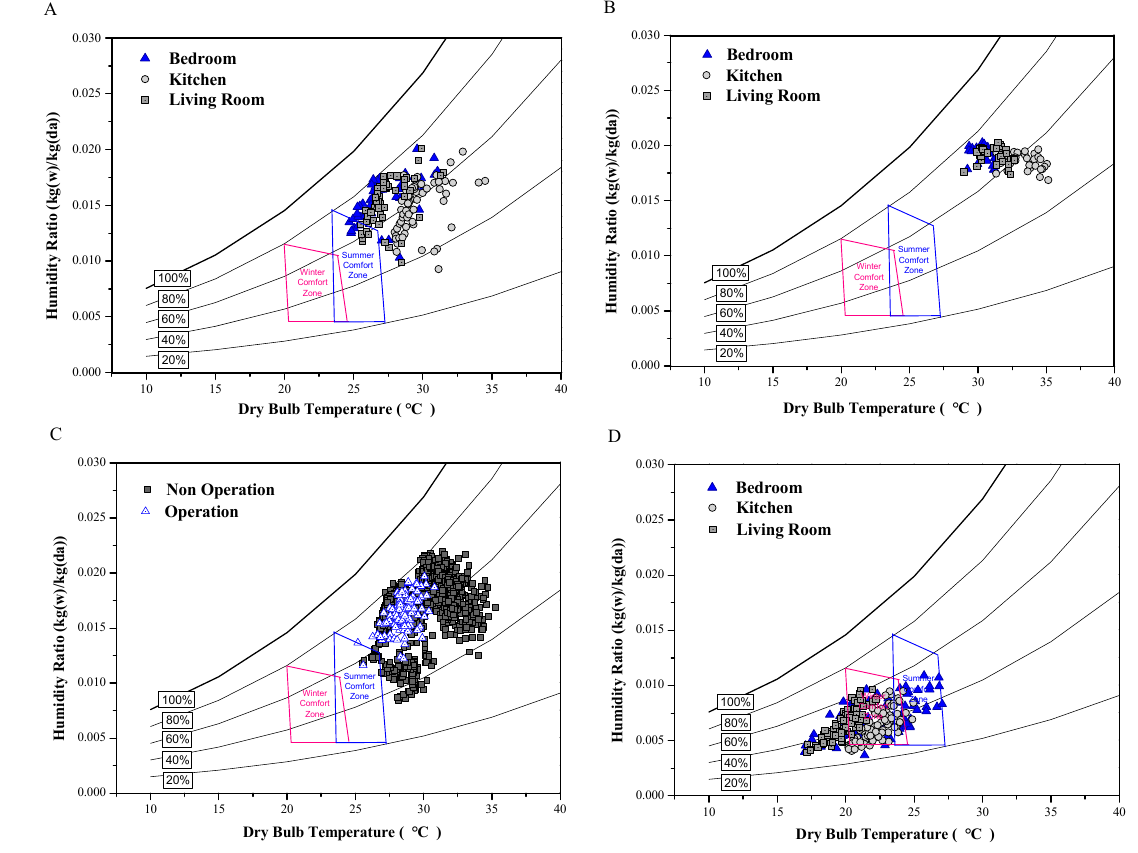
Figure 3. Indoor thermal conditions in the apartments during ( A ) Summer (Jul–Aug, 2016), ( B ) Tropical night in Summer, ( C ) AC was controlled in Summer and Tropical Night at the shows evaluation of thermal living room, and ( D ) Winter (Dec 2016–Feb 2017) .